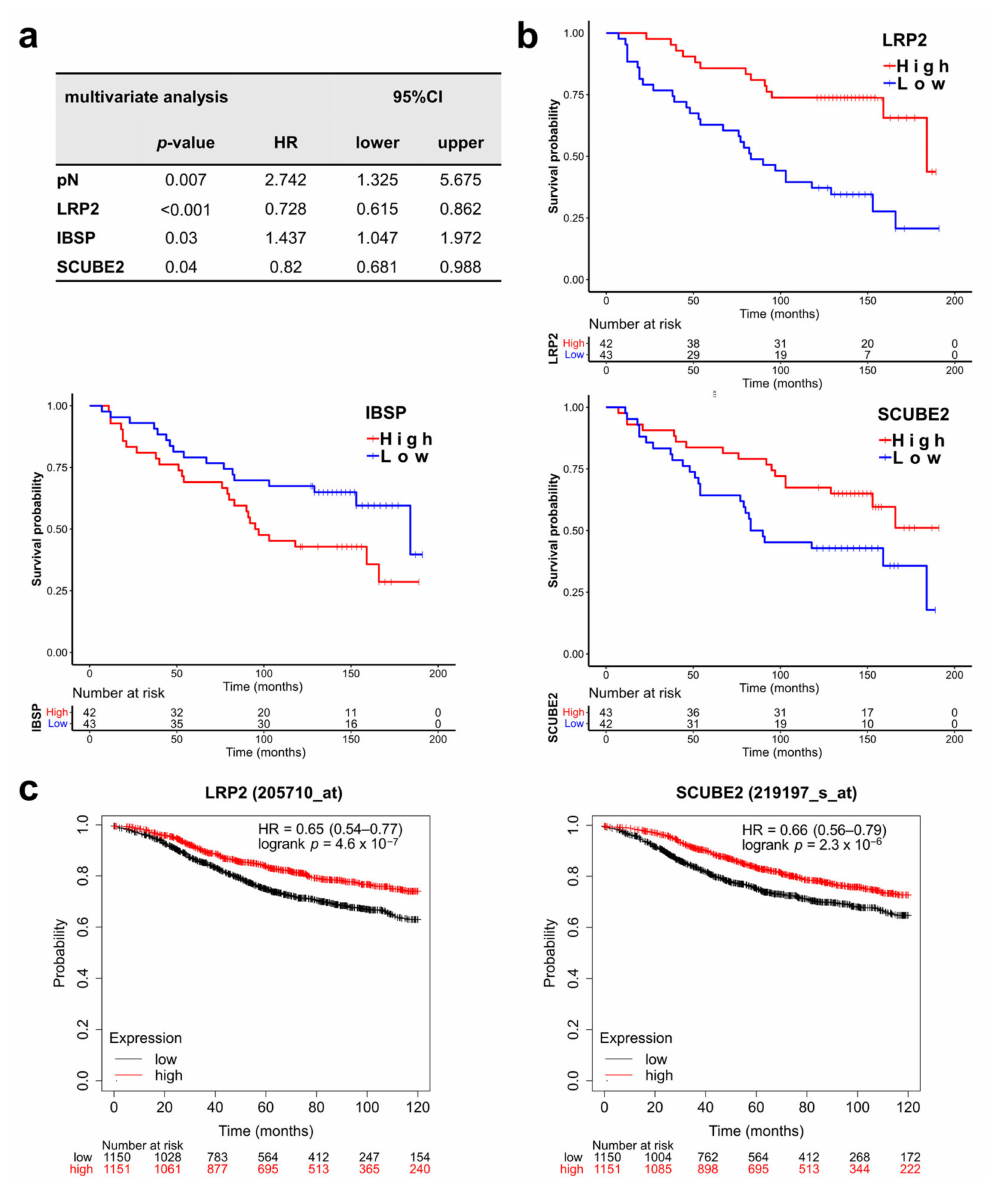
Figure 4. LRP2 , SCUBE2 , and IBSP are independent prognostic factors. ( a ) Multivariate analysis of differentially expressed BC360 signatures and single genes as well as pN and pT (detailed test results are in Table S2). ( b ) Overall survival curves were stratified by the genes that were significantly associated with survival in the multivariate analysis. ( c ) LRP2 and SCUBE2 are prognostic for patients from databases (Kaplan–Meier Plotter). CI, confidence interval. HR, hazard